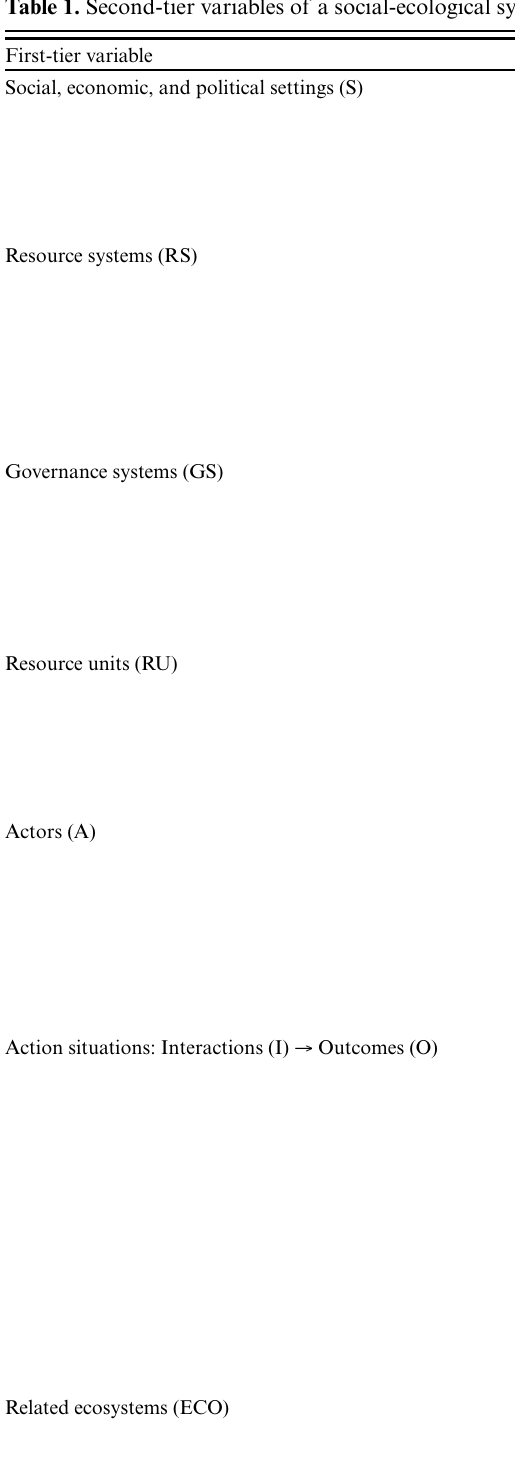
Table 1. Second-tier variables of a social-ecological system. Source: Adapted from Ostrom